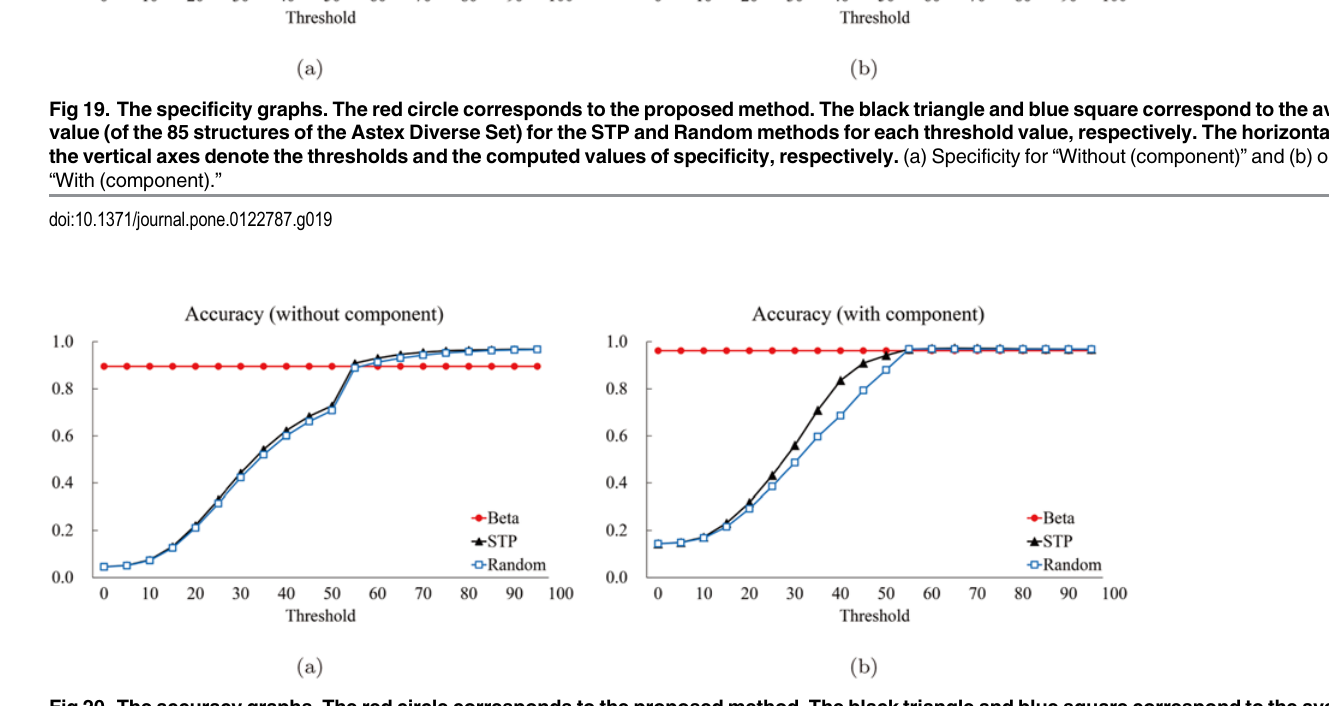
Fig 20. The accuracy graphs. The red circle corresponds to the proposed method. The black triangle and blue square correspond to the average value (of the 85 structures of the Astex Diverse Set) for the STP and Random methods for each threshold value, respectively. The horizontal and the vertical axes denote the thresholds and the computed values of accuracy, respectively. (a) Accuracy for “ Without (component) ” and (b) one for “ With (component). ”